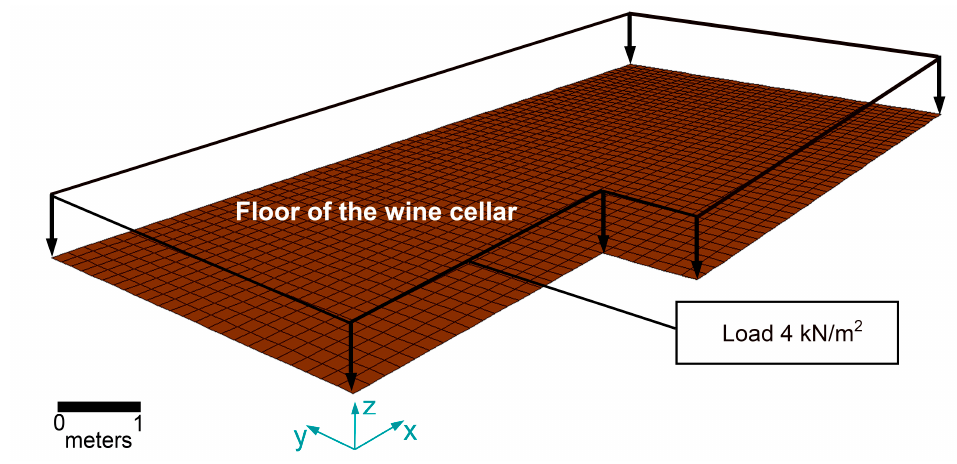
Figure 6. Service load of 4 kN/m 2 on the floor of the wine cellar.